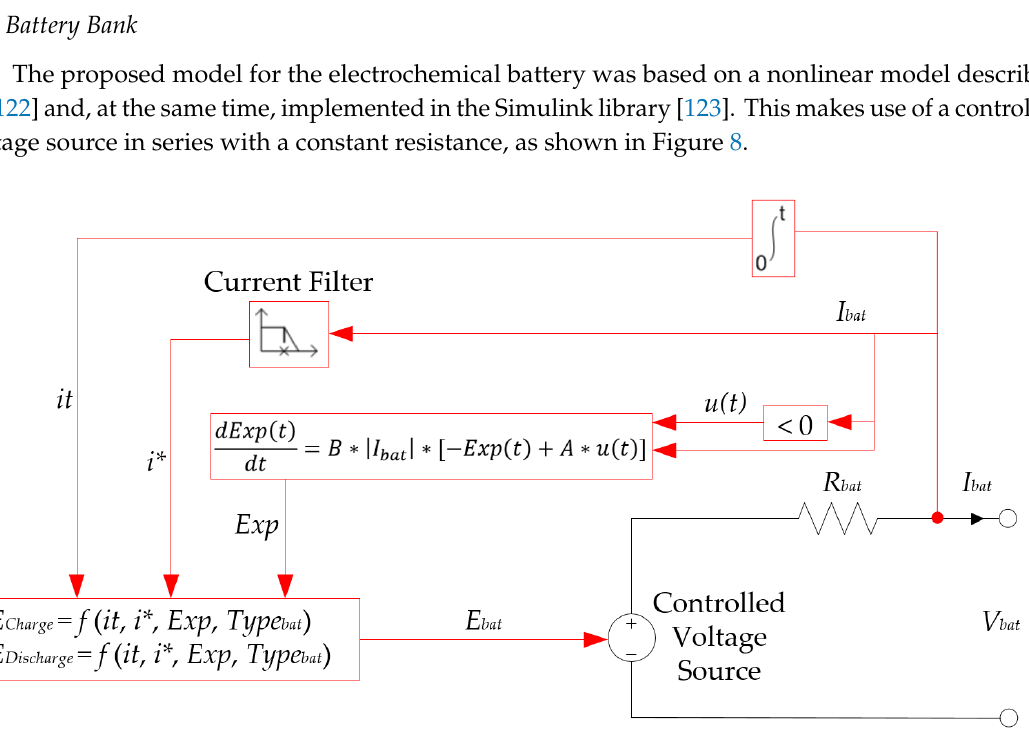
Figure 8. Nonlinear model of the battery [122]. The black lines indicate the flow of energy and the red lines indicate the flow of information.